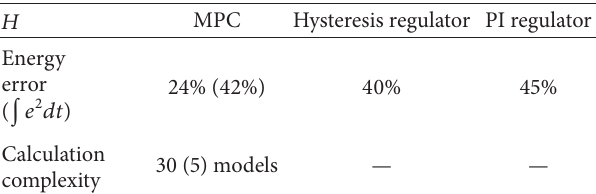
Table 2: Comparison of the results in the step test